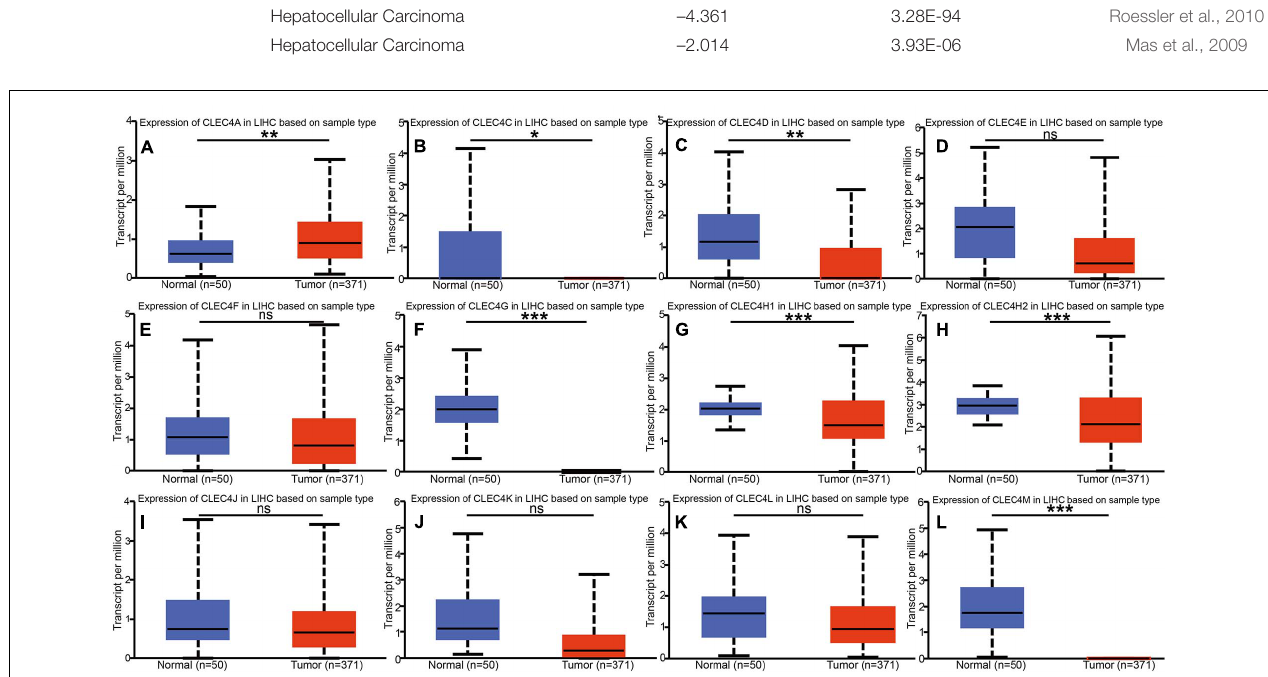
FIGURE 3 | mRNA expression of distinct CLEC4s in HCC tissues and adjacent normal liver tissues (UALCAN). mRNA expressions of 11 CLEC4s were found to be lower-expressed in primary HCC tissues compared to normal controls except CLEC4A. (A) CLEC4A; (B) CLEC4C; (C) CLEC4D; (D) CLEC4E; (E) CLEC4F; (F) CLEC4G; (G) CLEC4H1; (H) CLEC4H2; (I) CLEC4J; (J) CLEC4K; (K) CLEC4L; (L) CLEC4M. * p < 0.05; ** p < 0.01; *** p < 0.001; ns, not